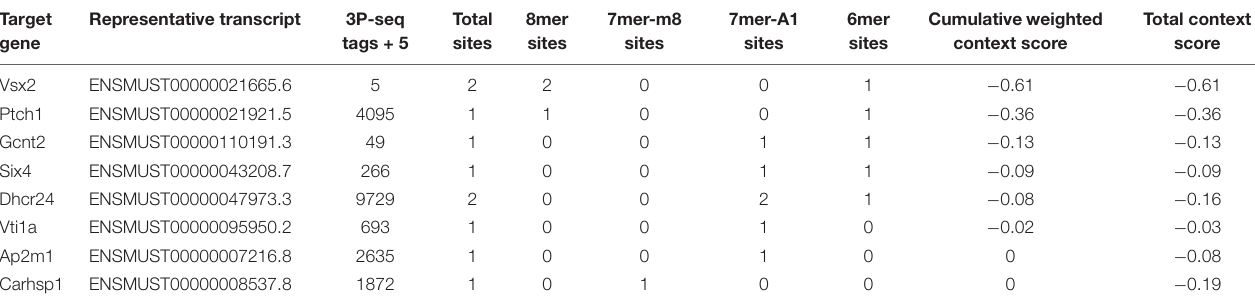
TABLE 1 | Targetscan7.2 predicts the mRNA targets of miR-342-5p. Target gene